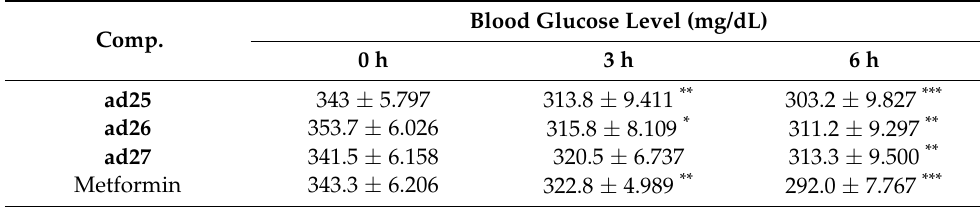
Table 41. Antidiabetic potential of the compounds ( ad25–ad27 ) in alloxan-induced diabetes in rats. Comp.